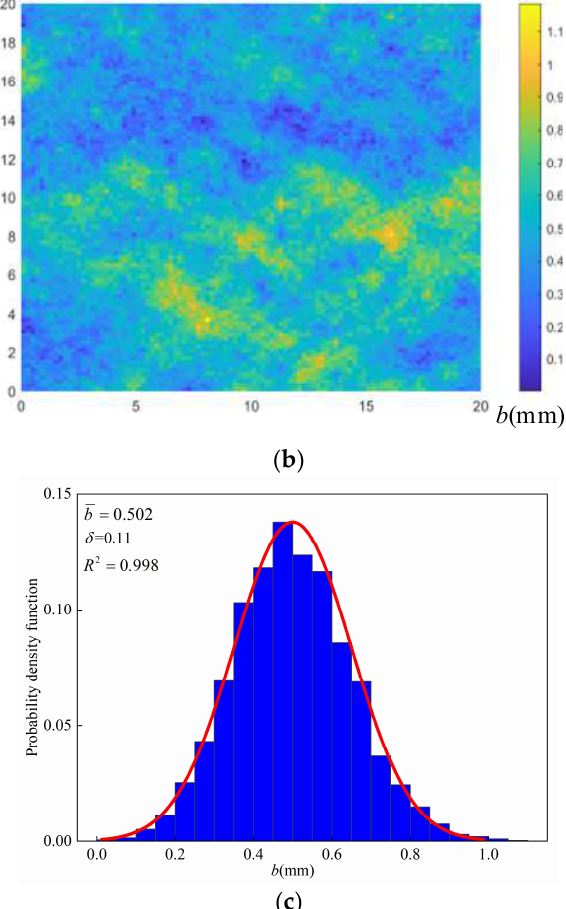
Figure 1. ( a ) The morphology of fracture surface in space; ( b ) aperture distribution in plane; ( c ) probability density function, where the red curve is a normal probability density function.